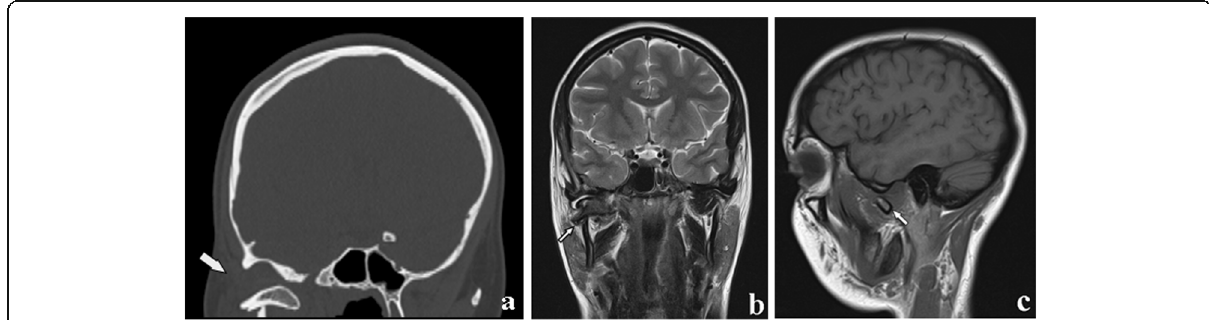
Fig. 18 Condylar process fracture. Dislocation. a Computed tomography coronal section. b , c Magnetic resonance T2w coronal image and T1w sagittal image of the same patient. The condylar head is in the horizontal position and completely outside the glenoid fossa (arrows)